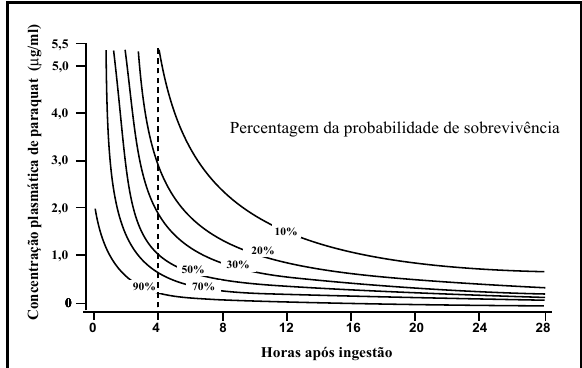
Figura 2 – Percentagem da probabilidade de sobrevivência do indivíduo após a ingestão do paraquat através da correlação da concentração plasmática em µ g/l e o tempo em horas após a ingestão, segundo Hart et al . modificado